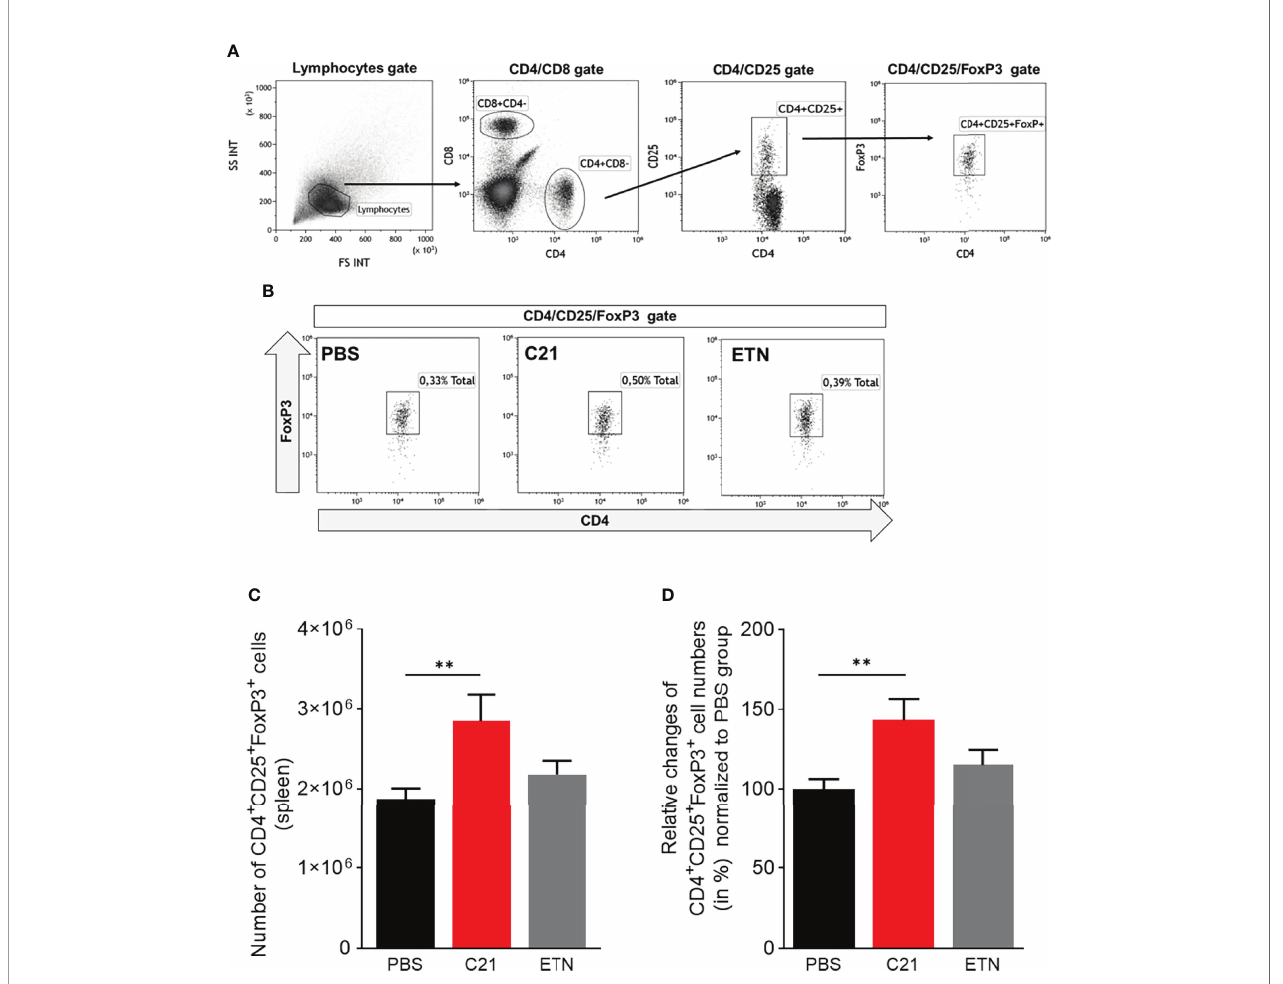
FIGURE 6 | C21-induced AT 2 R stimulation raises the numbers of regulatory T cells in CIA in the early therapeutic intervention trial. Splenocytes from CIA mice were isolated at day 47 after CII-immunisation and stained with fl uorochrome-conjugated antibodies against cell surface CD4, CD8, CD25 and intracellularFoxP3 and analyzed by fl ow cytometry. (A) Gating strategy to identify CD4 + CD25 + FoxP3 + Tregs. Lymphocytes were analyzed using forward scatter (FSC) and side scatter (SSC). Subgating of lymphocytes were performed resulting in CD8 versus CD4 dot plots followed by CD4 versus CD25 dot plots. Treg cells were enumerated by CD4 + CD25 + FoxP3 + Tregs. (B) Representative dot plots of each group (PBS, C21, ETN) are presented showing the frequencies (%) of CD4 + CD25 + FoxP3 + Tregs. (C) The absolute numbers of splenic CD4 + CD25 + FoxP3 + cells were calculated by using total spleen cell numbers. The results of one representative experiment are shown (PBS, n=10 mice; C21, n=8 mice; ETN, n=9 mice). P**<0.01. Values shown are the mean ± SEM. P-values were calculated using the Kruskal-Wallis test followed by Dunn ’ s post hoc test for multiple comparisons. (D) The summarized data of three independent CIA experiments were illustrated as relative changes (in %) normalized to the respective control group of each experiment (PBS = 100%) (PBS, n=32 mice; C21, n=26 mice; ETN, n=17 mice). P**<0.01. Values shown are the mean ± SEM. P-values were calculated by one-way ANOVA followed by Bonferroni ’ s multiple comparisons